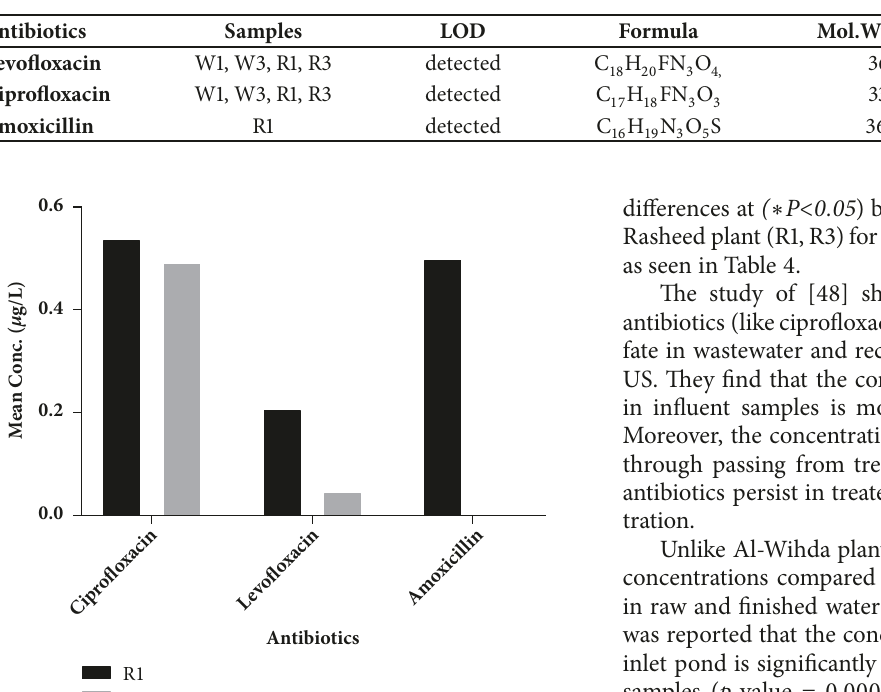
Table 3: Qualitative detection (LOD) of residual drugs by HPLC method.